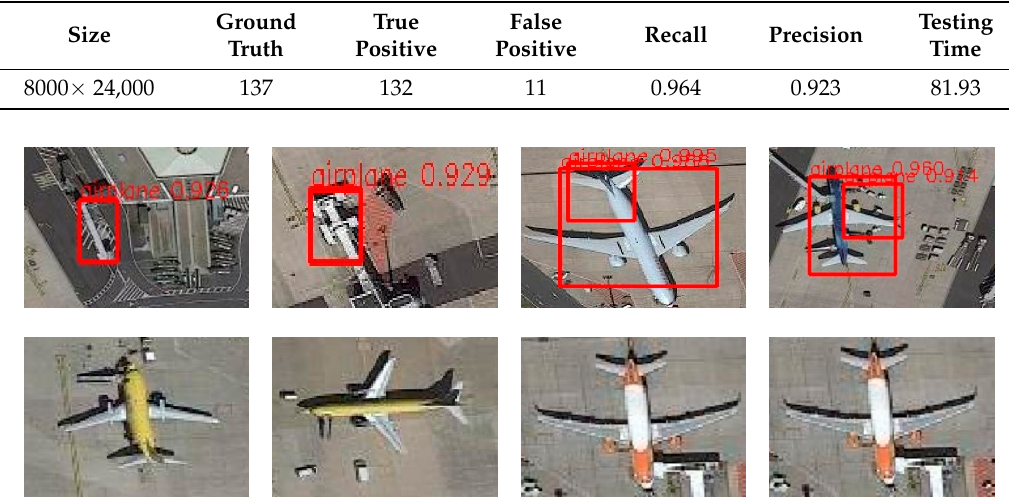
Table 7. Detection performance of our method in large range HRS imagery.